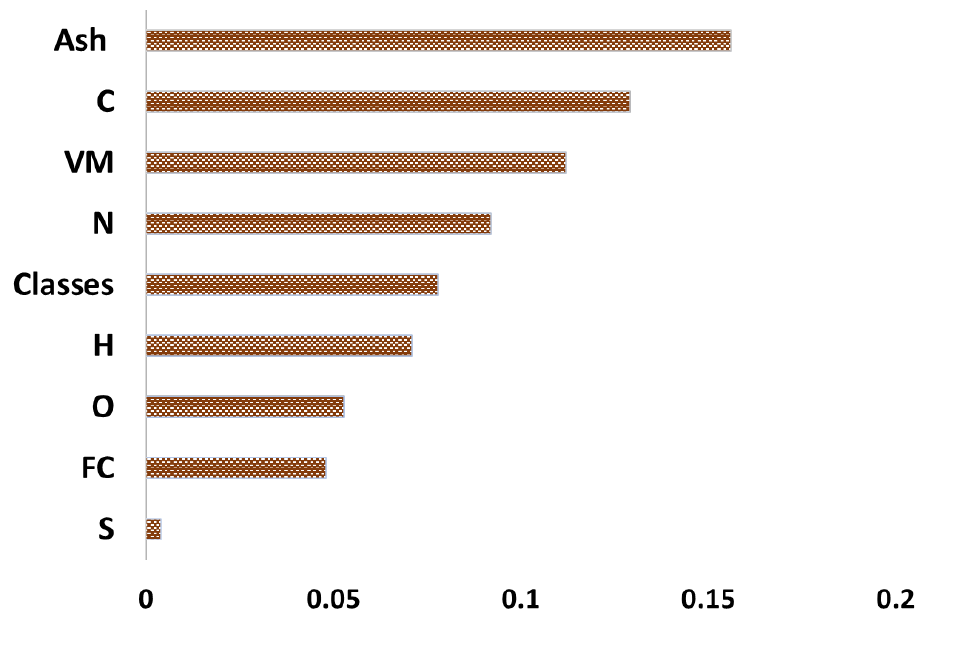
Figure 8. Feature importance of HHV.